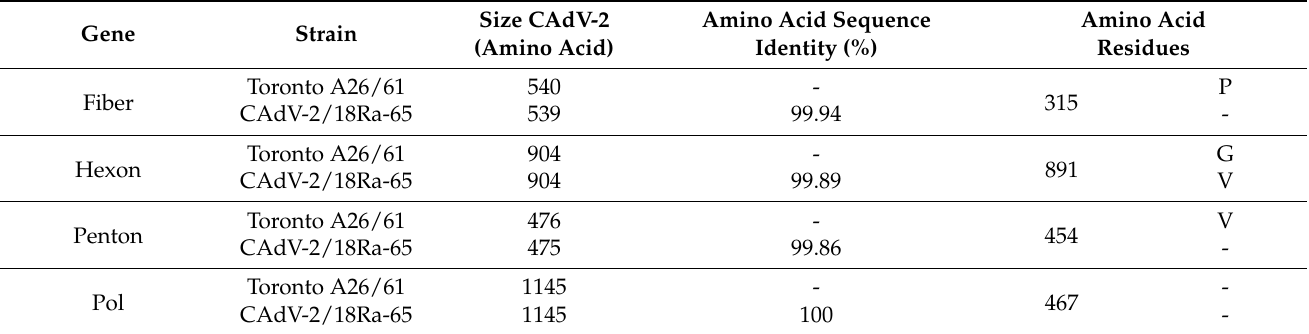
Table 4. Comparison of the size and amino acid sequence identity of the major genes (fiber, hexon, penton, and pol) between Toronto A26/61 (GenBank accession number U77082) and CAdV-2/ 18Ra-65